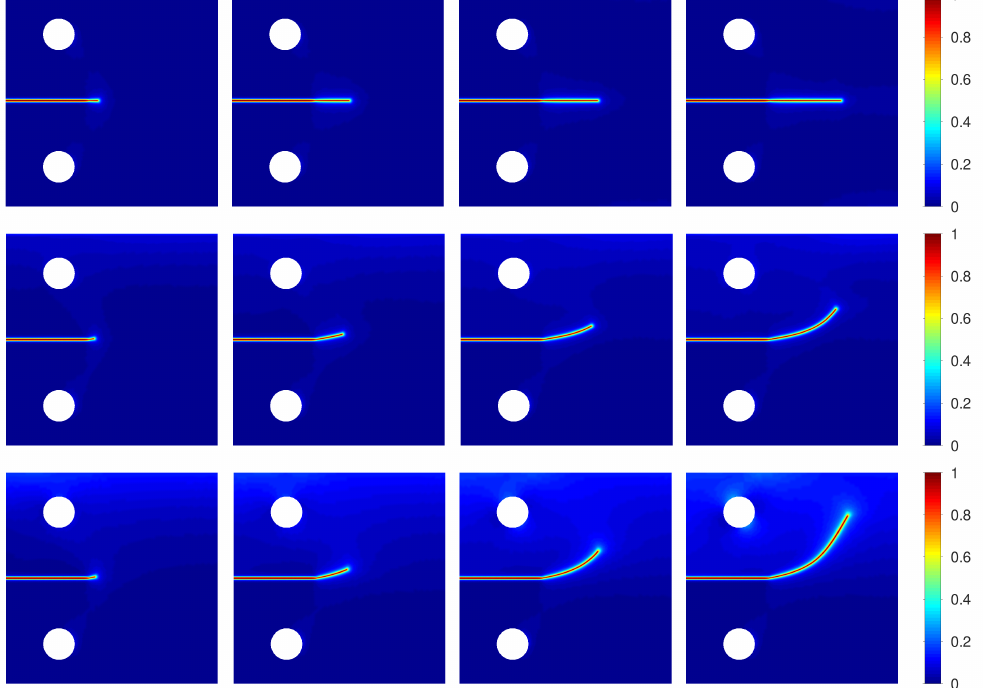
Figure 15. Snapshots of the crack paths. F-PFM ( upper ), TF-PFM1 ( middle ), and TF-PFM2 ( lower ) at t = 0.4, 0.6, 0.8, 1 ( left to right ). For TF-PFM1 and TF-PFM2, we set Θ D = 10 and δ = 0.5. Here, the color represents the value of z .